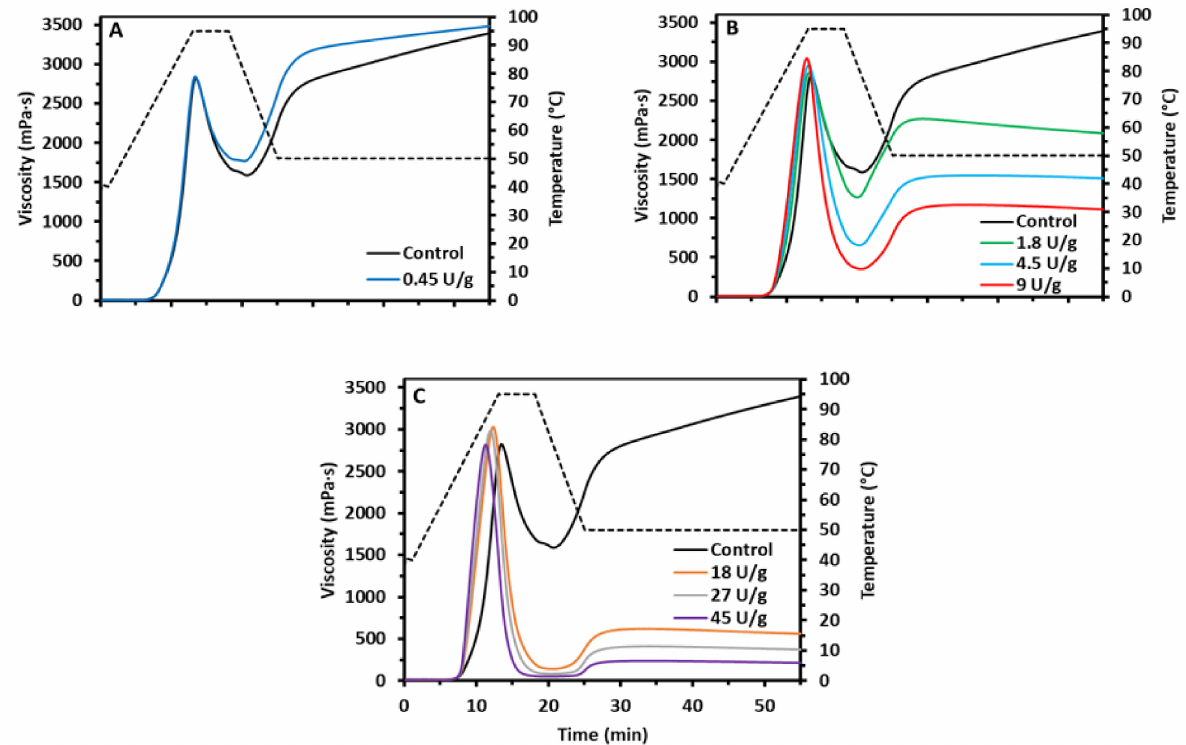
Figure 1. Rapid visco analysis (RVA) profiles of starch suspensions [10.0% w/w dry matter (dm)] supplemented with different dosages of amylomaltase (AMM): ( A ) 0 (control) and 0.45, ( B ) 0, 1.8, 4.5 and 9 and ( C ) 0, 18, 27 and 45 U/g starch dm. The temperature profile is denoted with a dotted